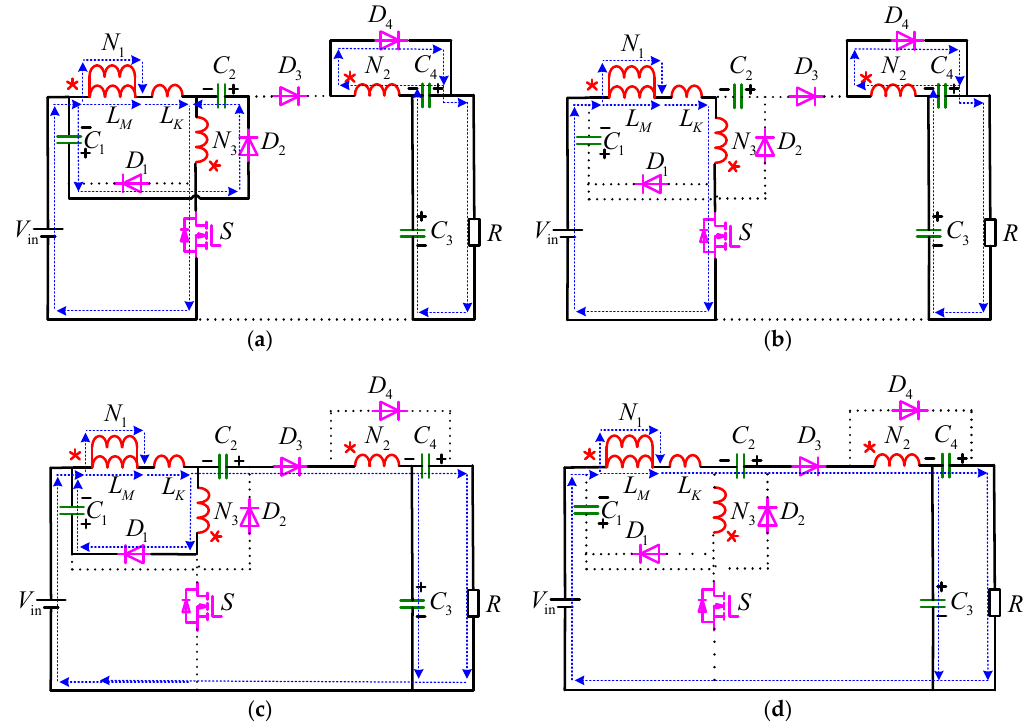
Figure 3. Operating modes during one switching period at CCM: ( a ) Mode I; ( b ) Mode II; ( c ) Mode III; and ( d ) Mode IV.